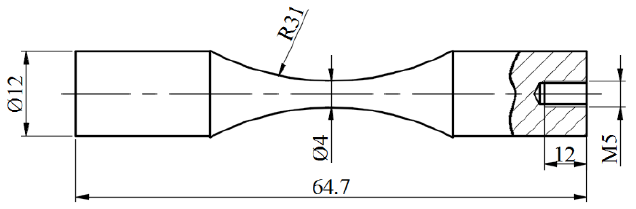
Figure 2. Geometry and dimensions of the fatigue sample (unit: